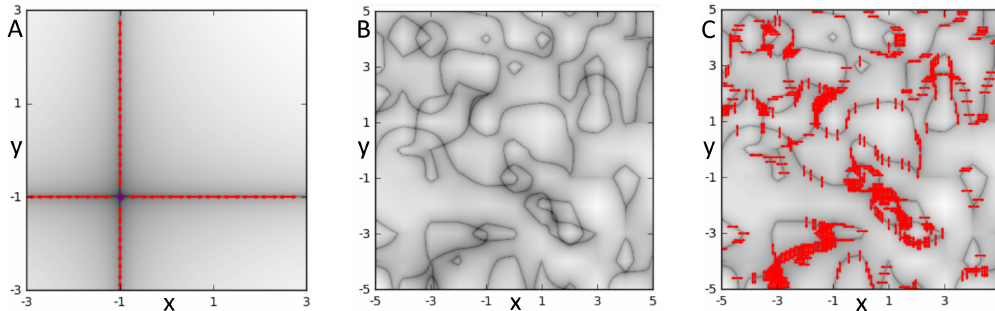
Figure 15: Curvature in the pure diagonal model. A: Heat map of the time-dilation factor γ [ Eq. (118) ] for the “disorder space” diagonal manifold, with δ v 1 δ v 2 = y . We note the singularities lie along the lines { x = − 1, y = − 1 } . B: A heat 2 map of the time-dilation factor for a random realization of purely diagonal QGD. C: The heat map in B annotated to mark the collimation angles of the nematic singular- ities, which we note are all either horizontal or